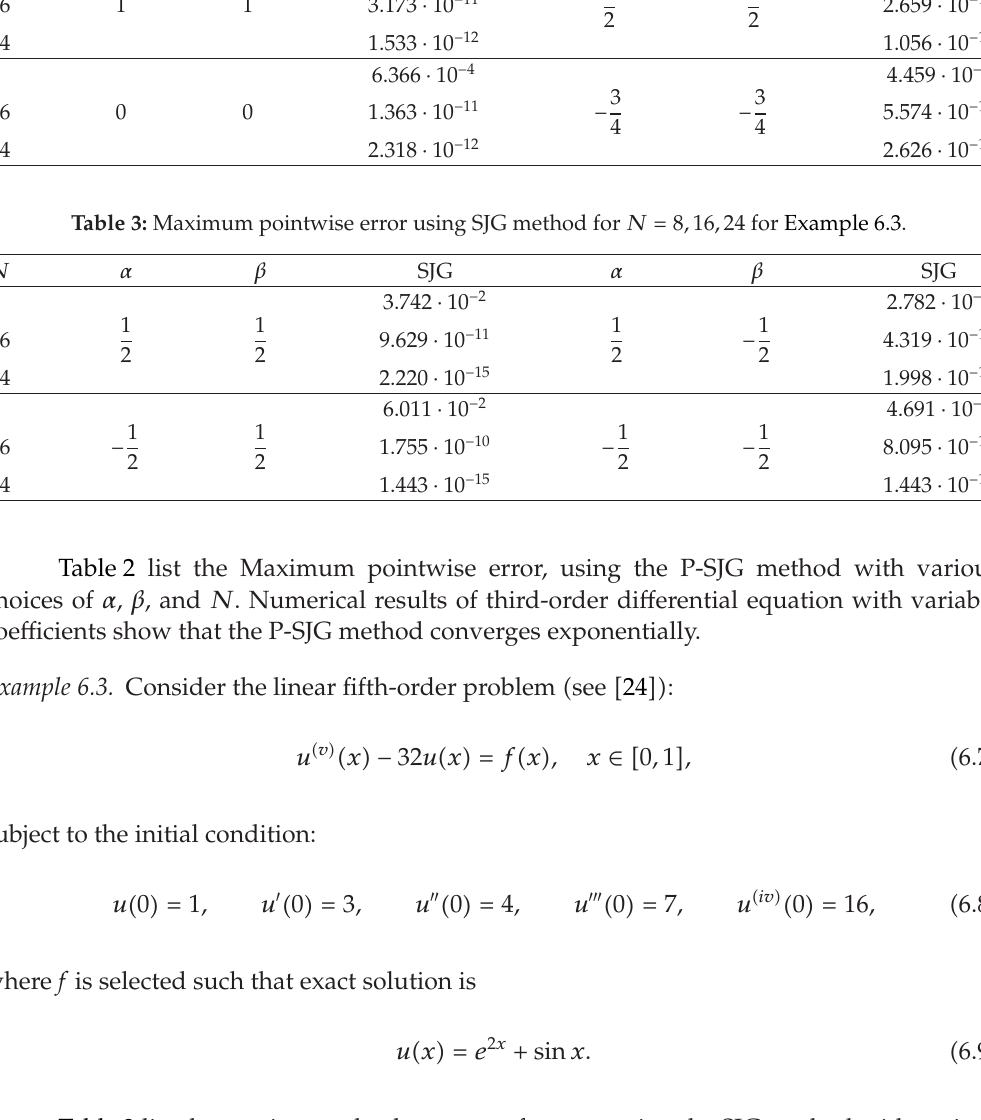
Table 3 list the maximum absolute error of u − u N using the SJG method with various Table 2 in (cid:4) 24 (cid:5)(cid:7)